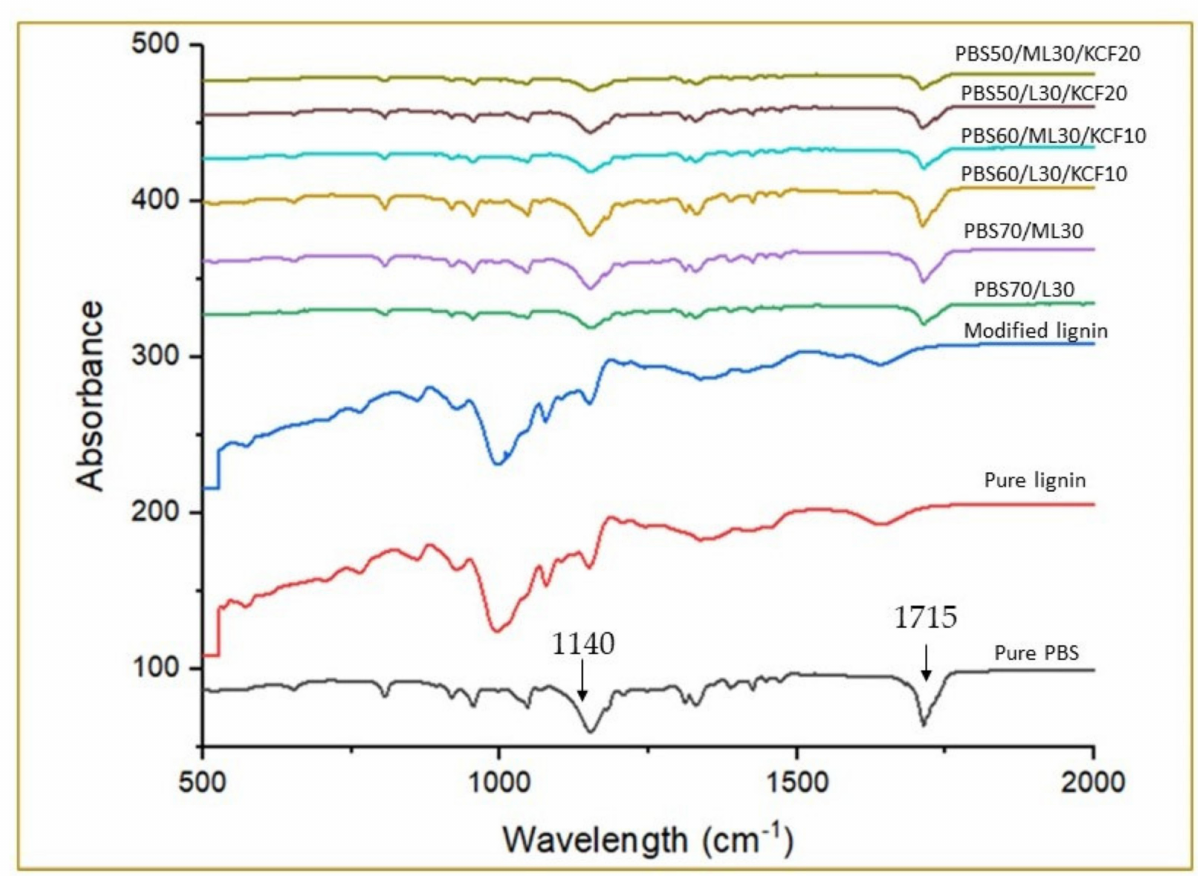
Figure 2. ATR-Fourier-transform infrared spectrometer (FTIR) of PBS and its composites. Note: Poly (butylene succinate) (PBS), Lignin (L), Modified Lignin (ML), Kenaf Core Fiber